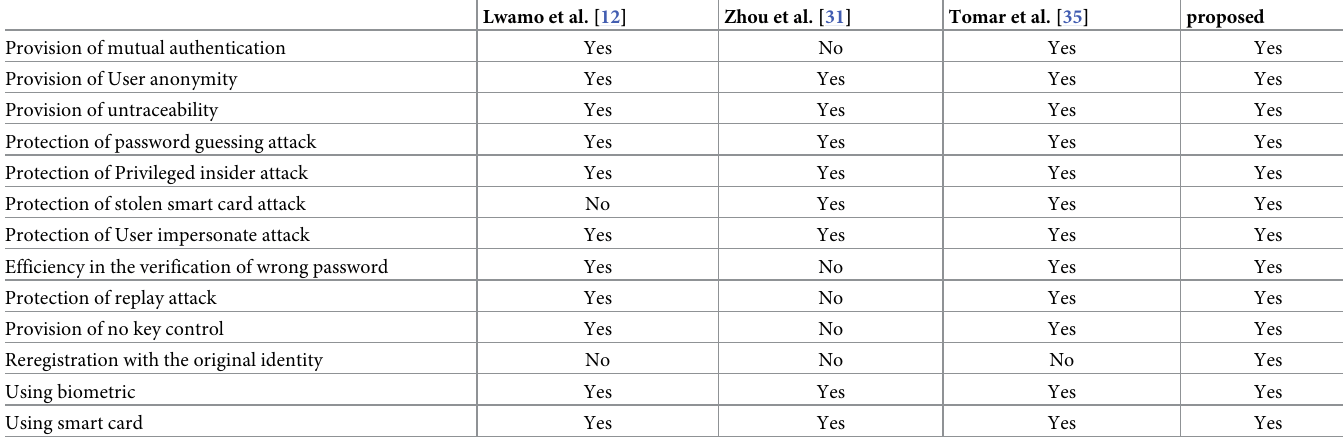
Table 7. Comparative evaluation of the security function between the proposed scheme and other